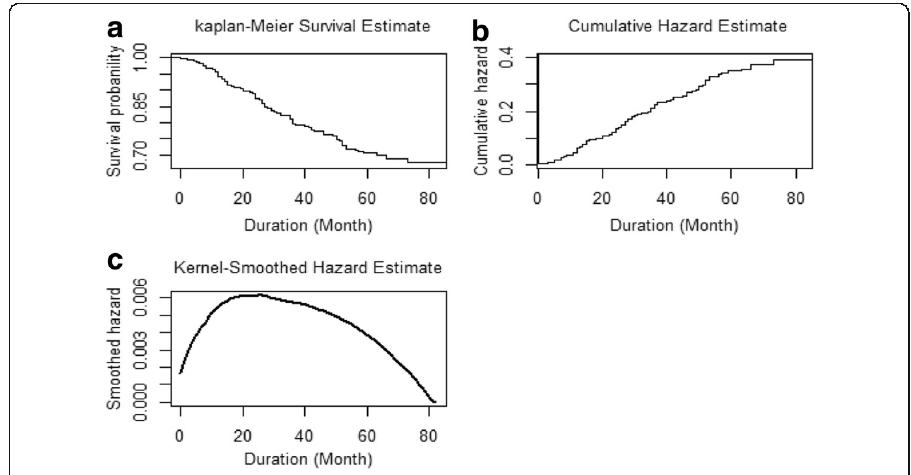
Fig. 1 The nonparametric survival and hazard rate estimation. a Kaplan-Meier survival estimate. b Cumulative hazard estimate. c Kernel-smoothed hazard estimate